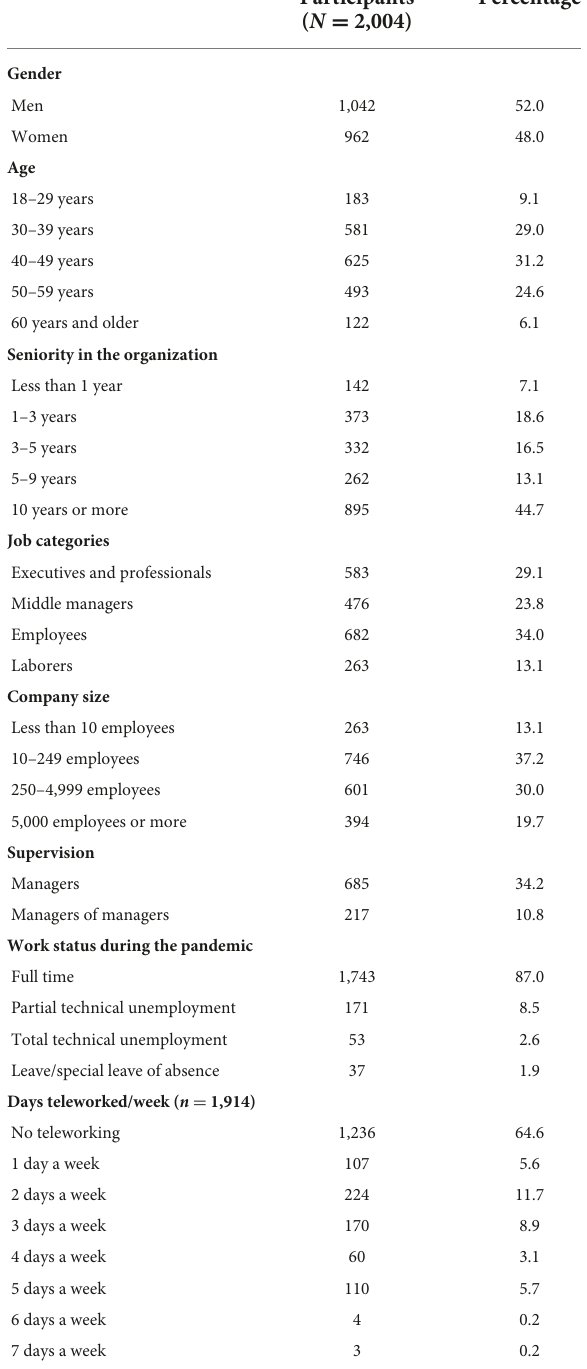
TABLE 1 Characteristics of study